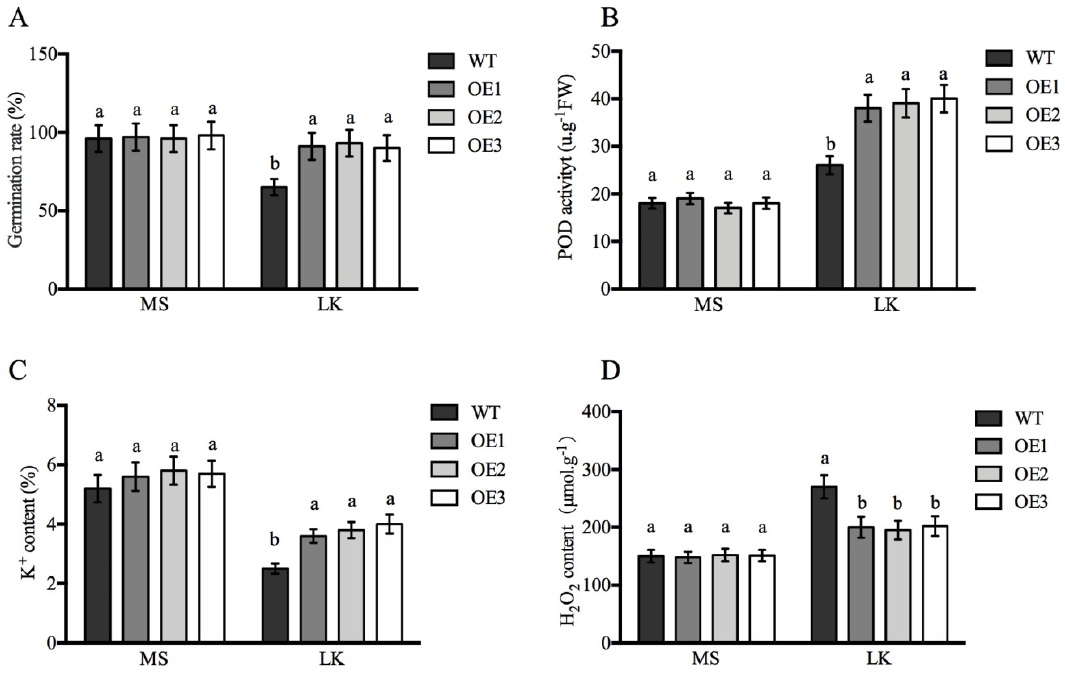
Figure 7. The physiological parameter analysis of wild-type and ApCPX1 transgenic tobacco lines under MS and LK conditions. Note ( A ) germination rate; ( B ) POD activity; ( C ) K + content; ( D ) H 2 O 2 content. Values are the mean ± SD ( n = 3), and different letters indicate significant differences ( p < 0.05) between the treatments. MS indicates MS medium, LK indicates LK medium (containing 10 μ m K + ).